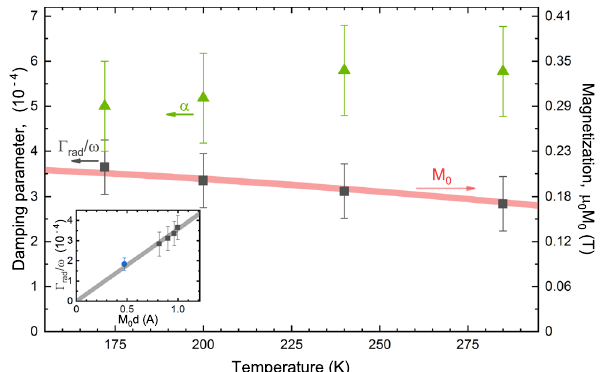
Fig. 5 Temperature dependence of the damping parameters. The left scale corresponds to the dimensionless radiative damping Γ rad / ω (black squares) and intrinsic damping α (green triangles) parameters in the temperature range T = 170 – 290 K, as observed on the d = 6.1 μ m thick yttrium-iron-garnet (YIG) sample. Error bars represent the standard deviation of the measured values at various frequencies in the ν = 40 – 190 GHz range. For comparison, red line shows the temperature dependence of the M 0 saturation magnetization of YIG, reproduced from the literature 64 , on the right scale. In the inset, the radiative damping versus the magnetic moment per unit area, M 0 d , is presented. Black squares correspond to the 6.1 μ m thick YIG sample, while the blue circle to the 3 μ m thick YIG fi lm. Gray line shows a linear fi t of the measured